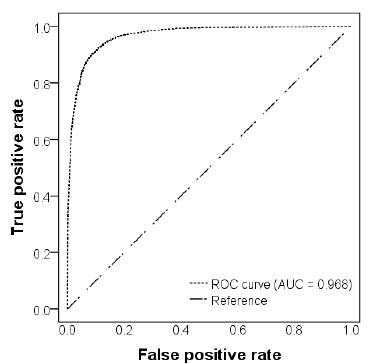
Figure 9. Receiver operating characteristic (ROC) curve and area under the curve (AUC).